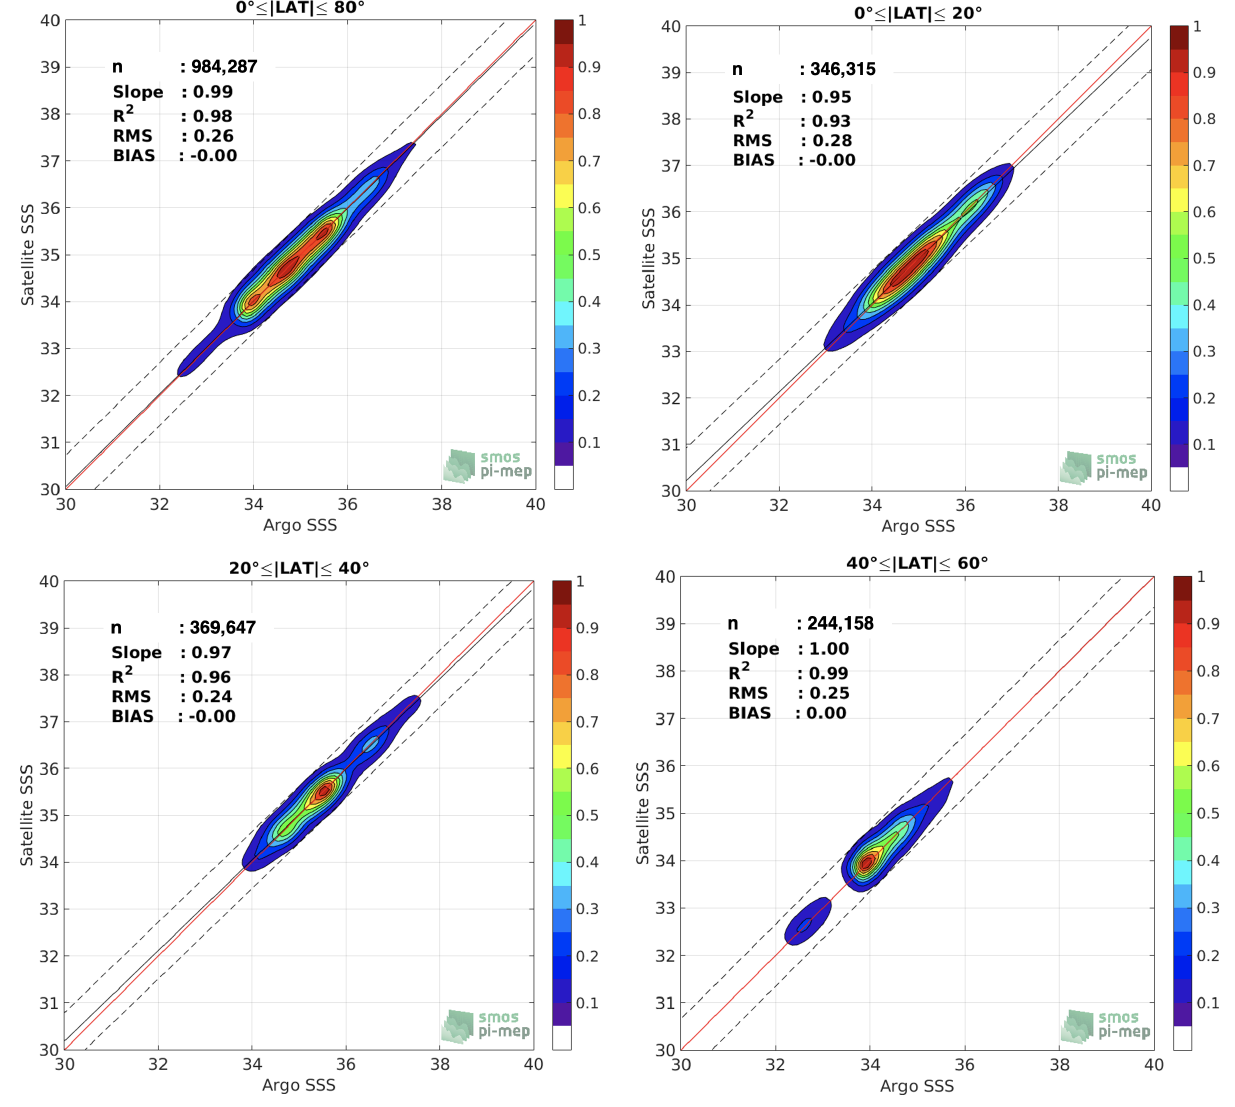
Figure 11. Contour maps of the concentration of CCI SSS L4 Merged-OI v3.2—30-day running (ESA) SSS ( y -axis) versus Argo SSS ( x -axis) at match-up pairs for different latitude bands. For each plot, the red line shows x = y. The black thin and dashed lines indicate a linear fit through the data cloud and the ± 95% confidence levels,